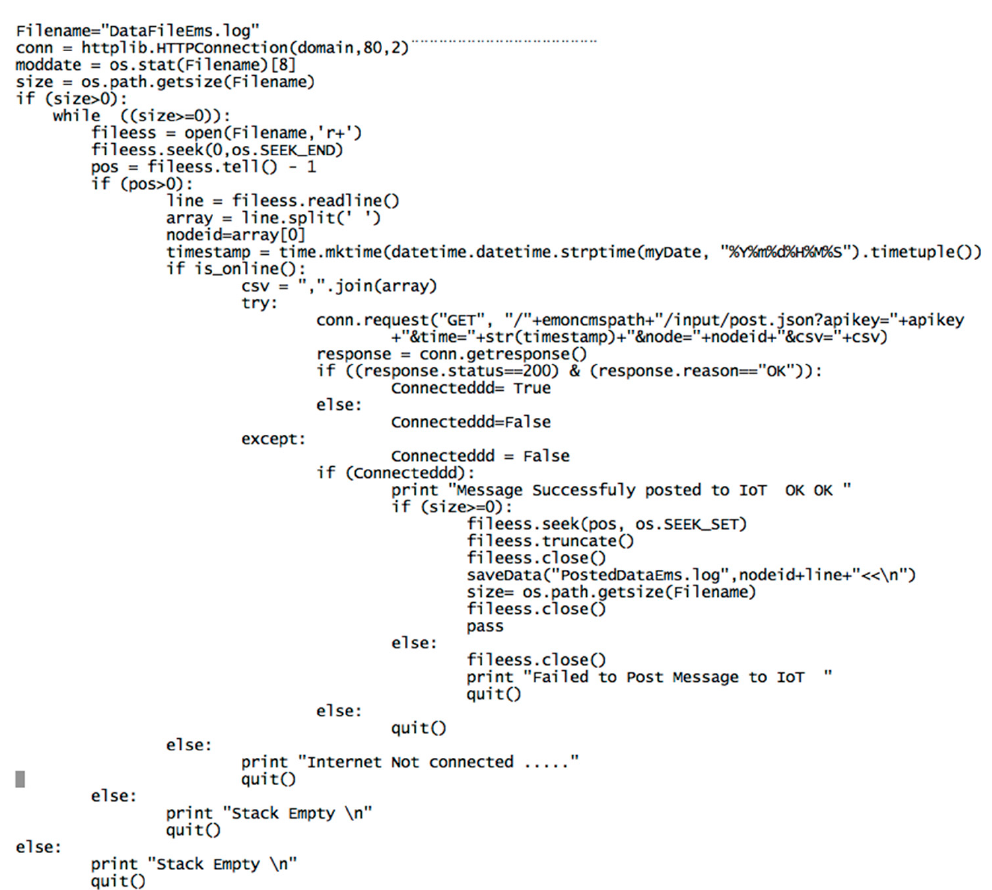
Figure 7. Message resubmission after Internet connection code Fragment.